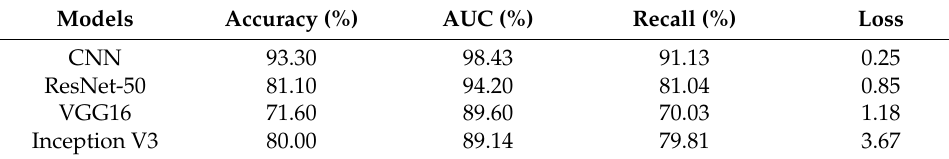
Table 3. Deep learning models’ performance on brain tumor detection.